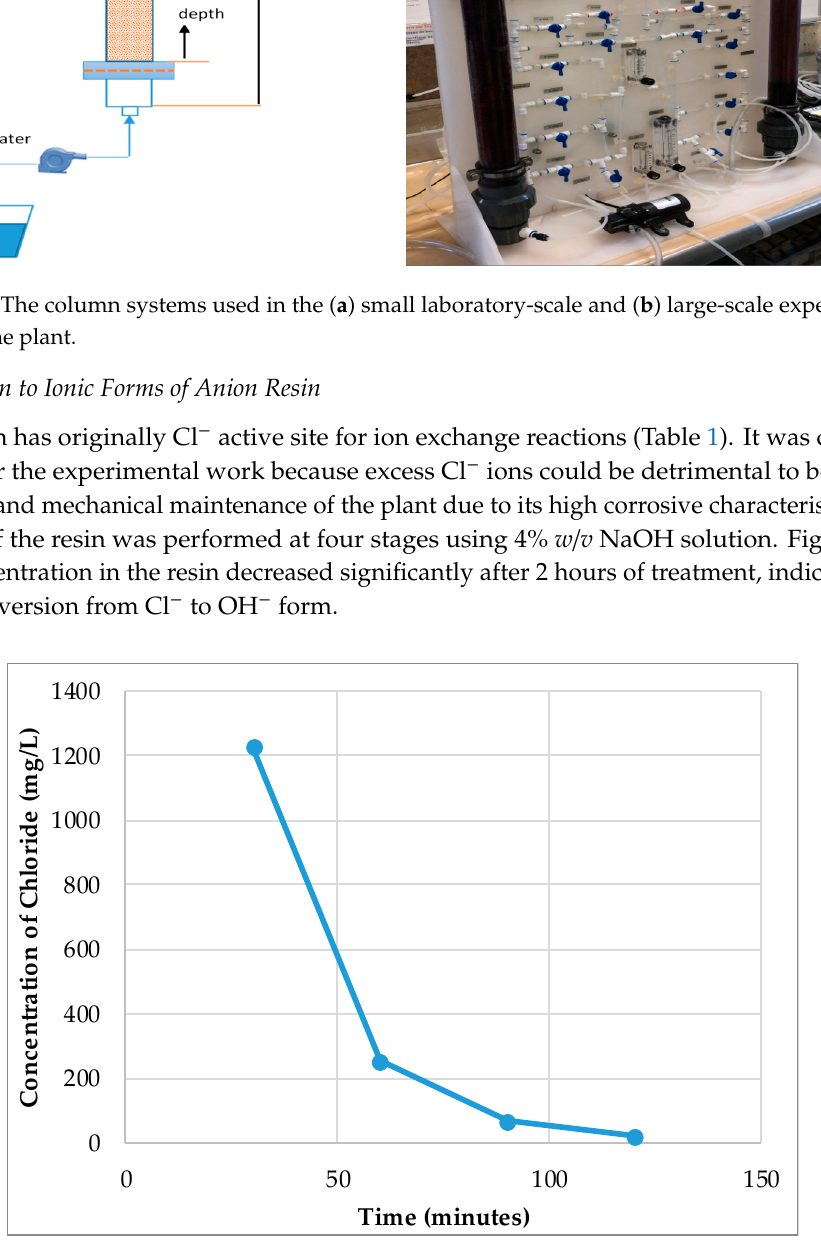
Figure 2. Conversion of Selion SBA 2000 resin from Cl − to OH − form.